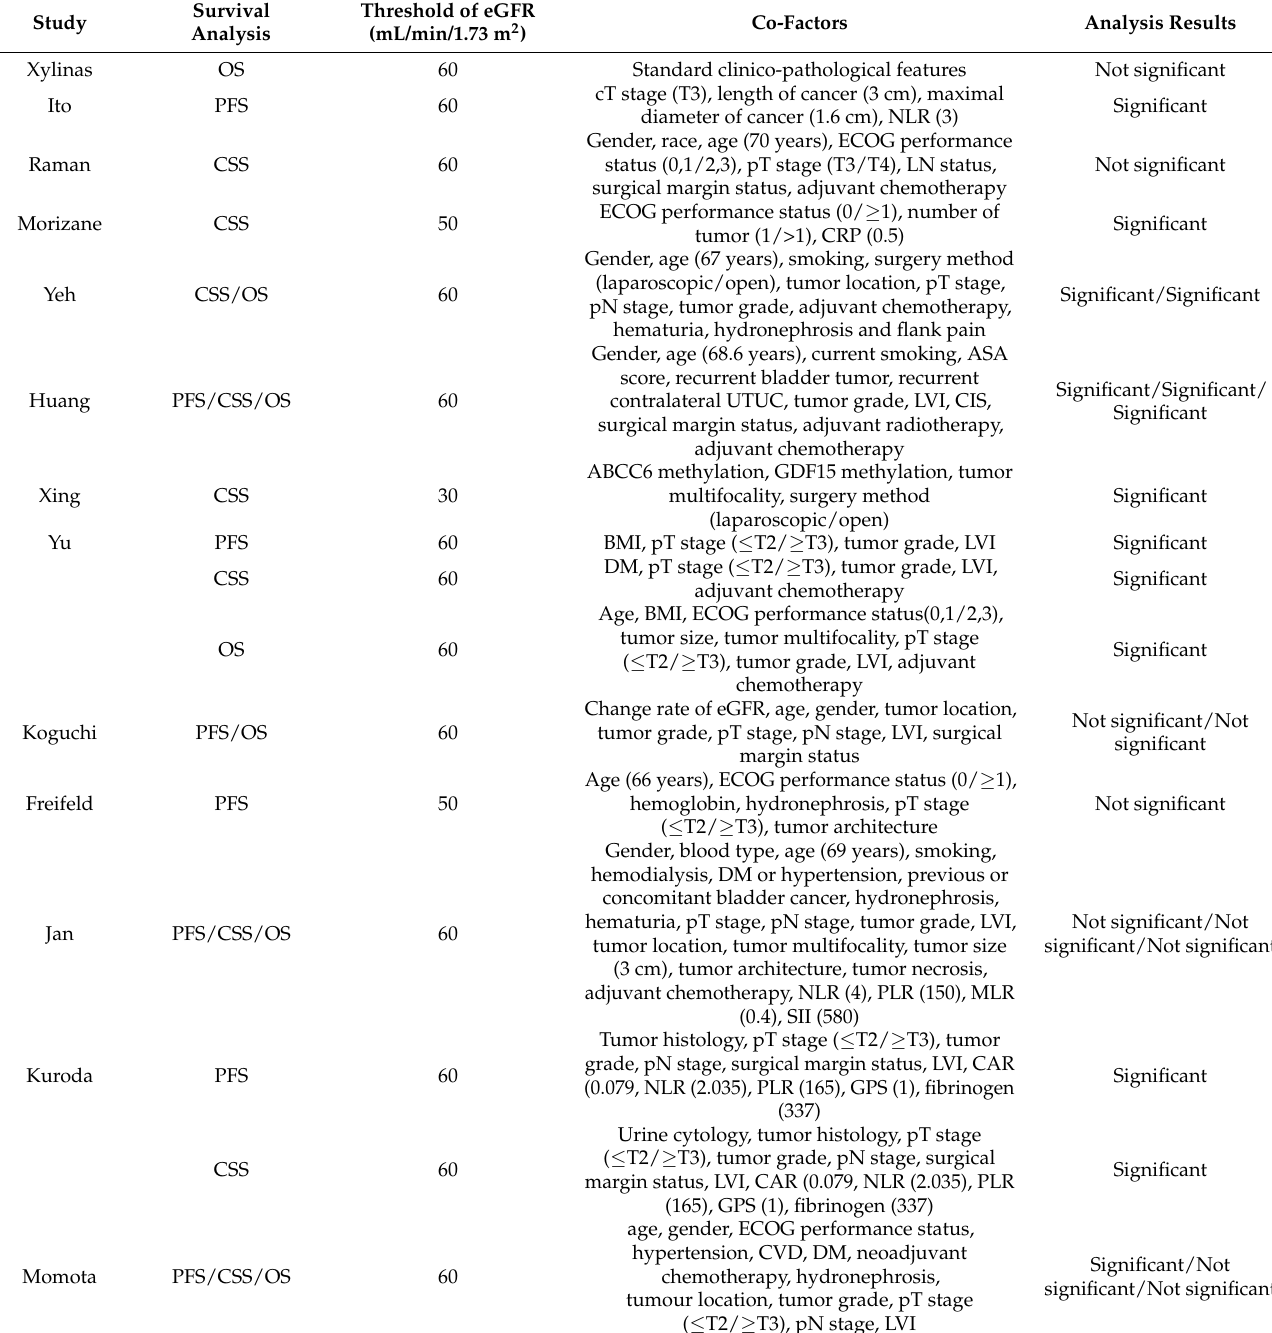
Table 5. Estimation of hazard